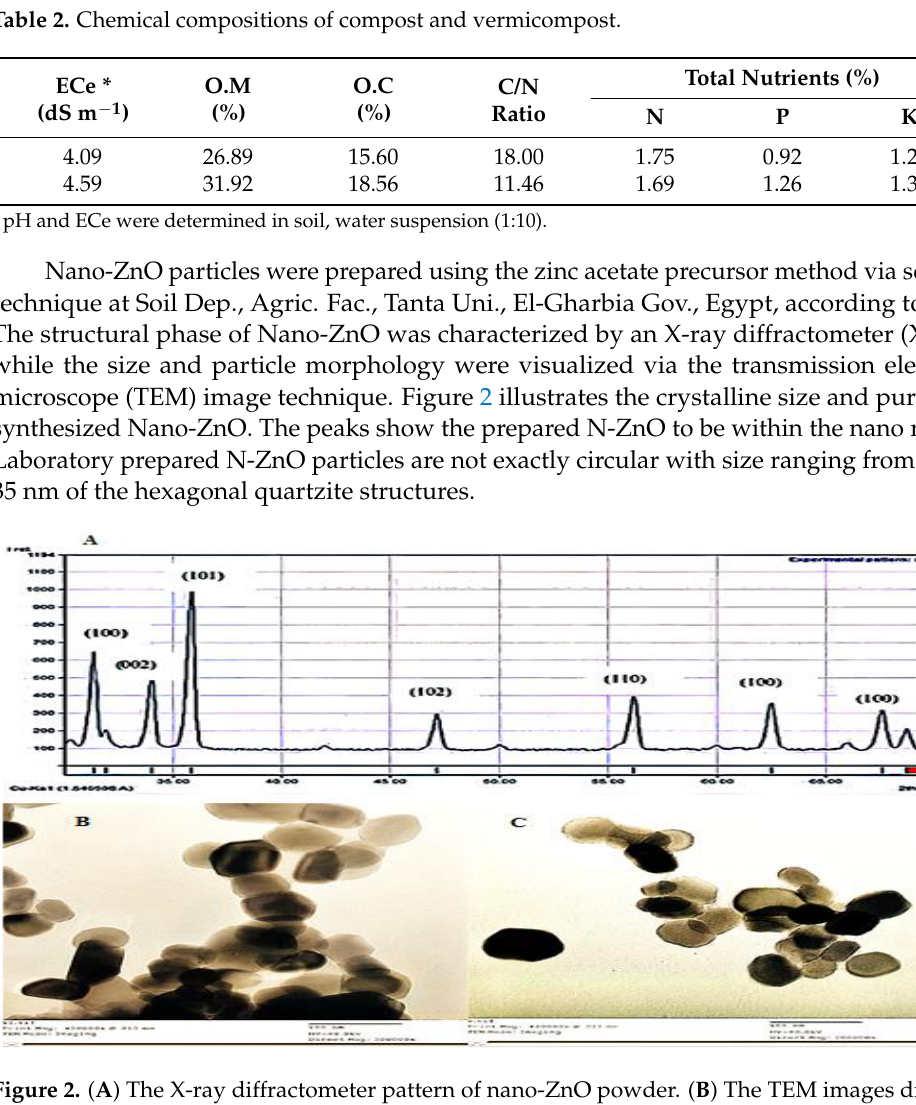
Figure 2. ( A ) The X-ray diffractometer pattern of nano-ZnO powder. ( B ) The TEM images display the diffusion and structural characteristics. ( C ) Shows the laboratory prepared Nano-ZnO particles.